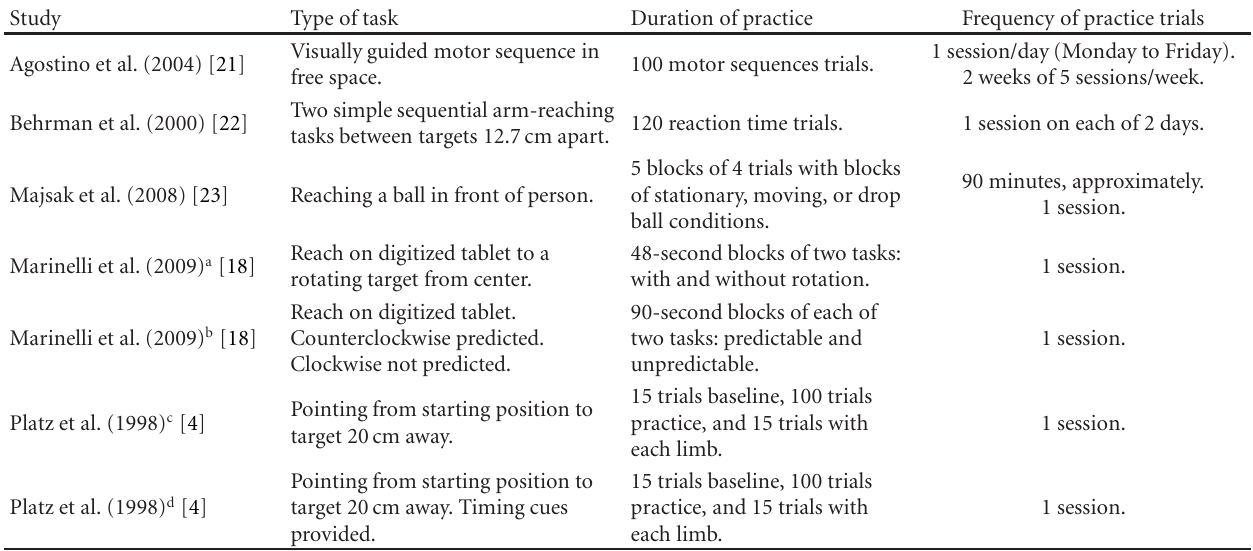
Table 4: Description of the motor learning paradigms in the studies used in the